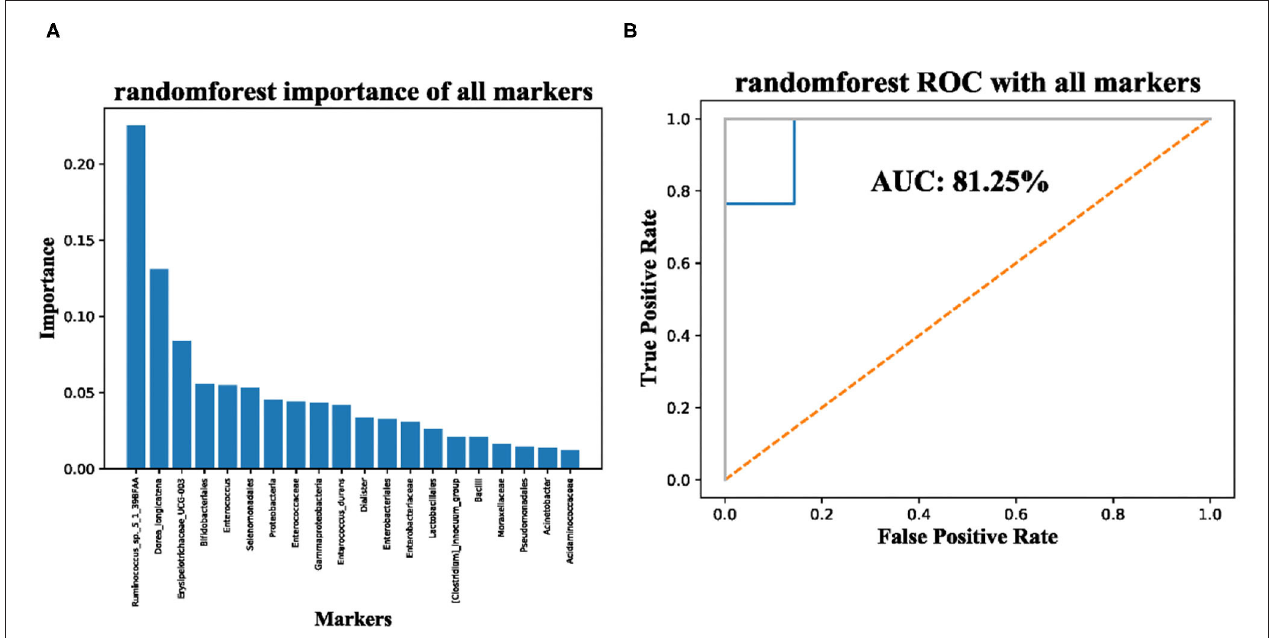
FIGURE 3 | Significantly enriched taxa in the guts of sepsis patients are potential makers for diagnosis of sepsis. (A) importance of significantly enriched taxa; (B) AUC of significantly enriched taxa used for sepsis